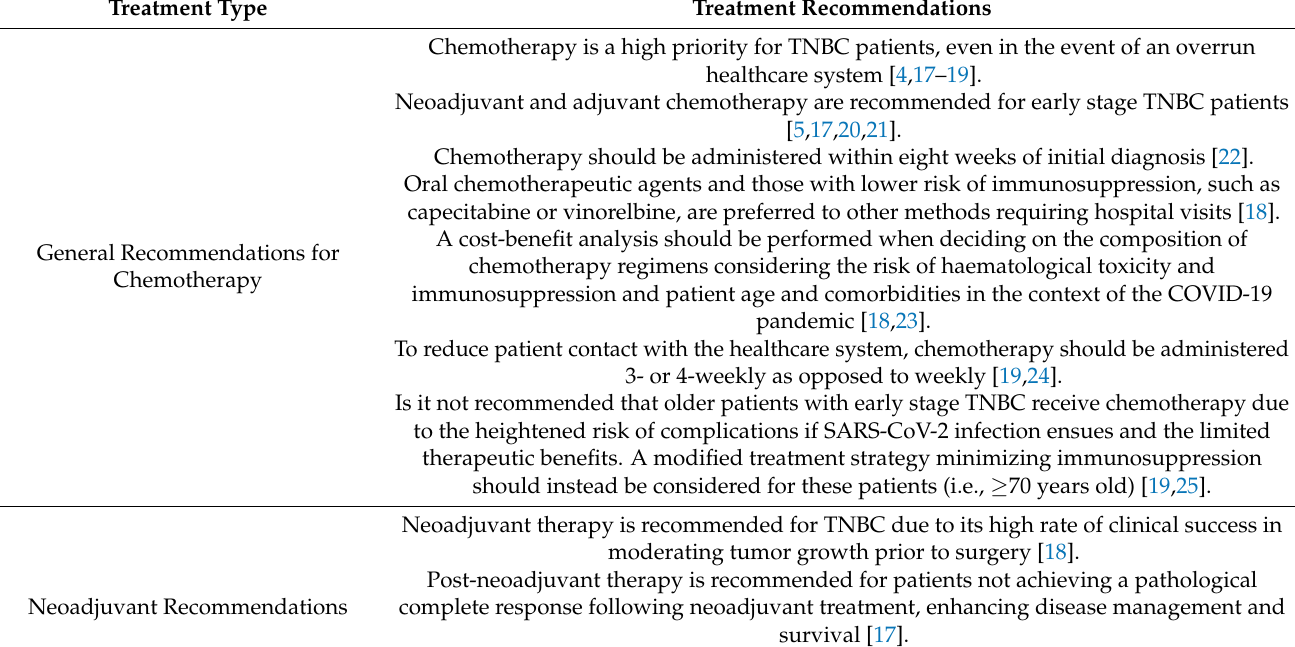
Table 1. Chemotherapy and targeted therapy recommendations for TNBC patients during